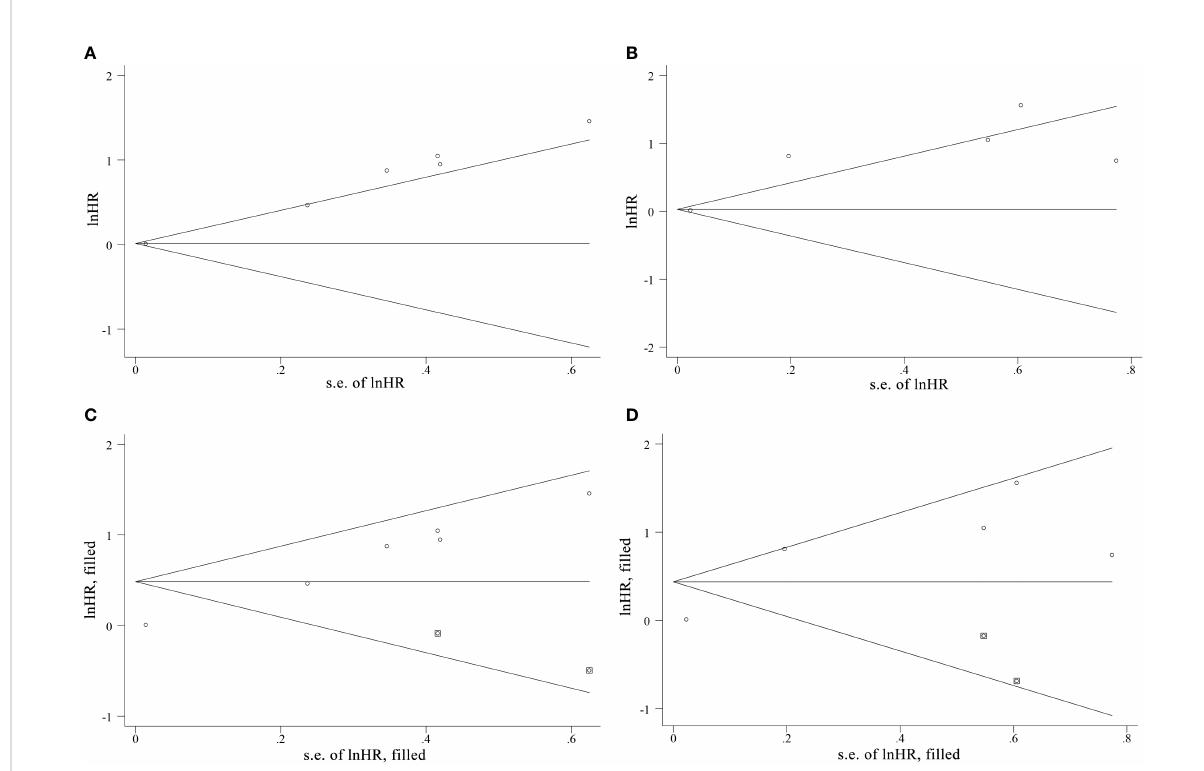
FIGURE 7 The funnel plots of Begg ’ s test and the trim-and- fi ll method of publication bias analysis for (A, C) PFS and (B, D)